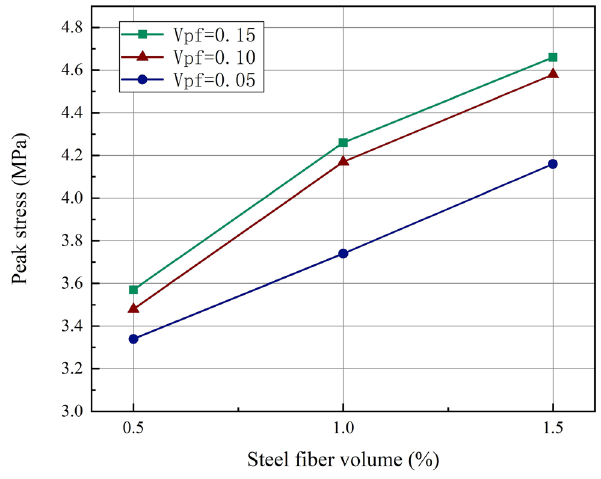
Figure 13: Peak stress values of the model for di ff erent fi ber